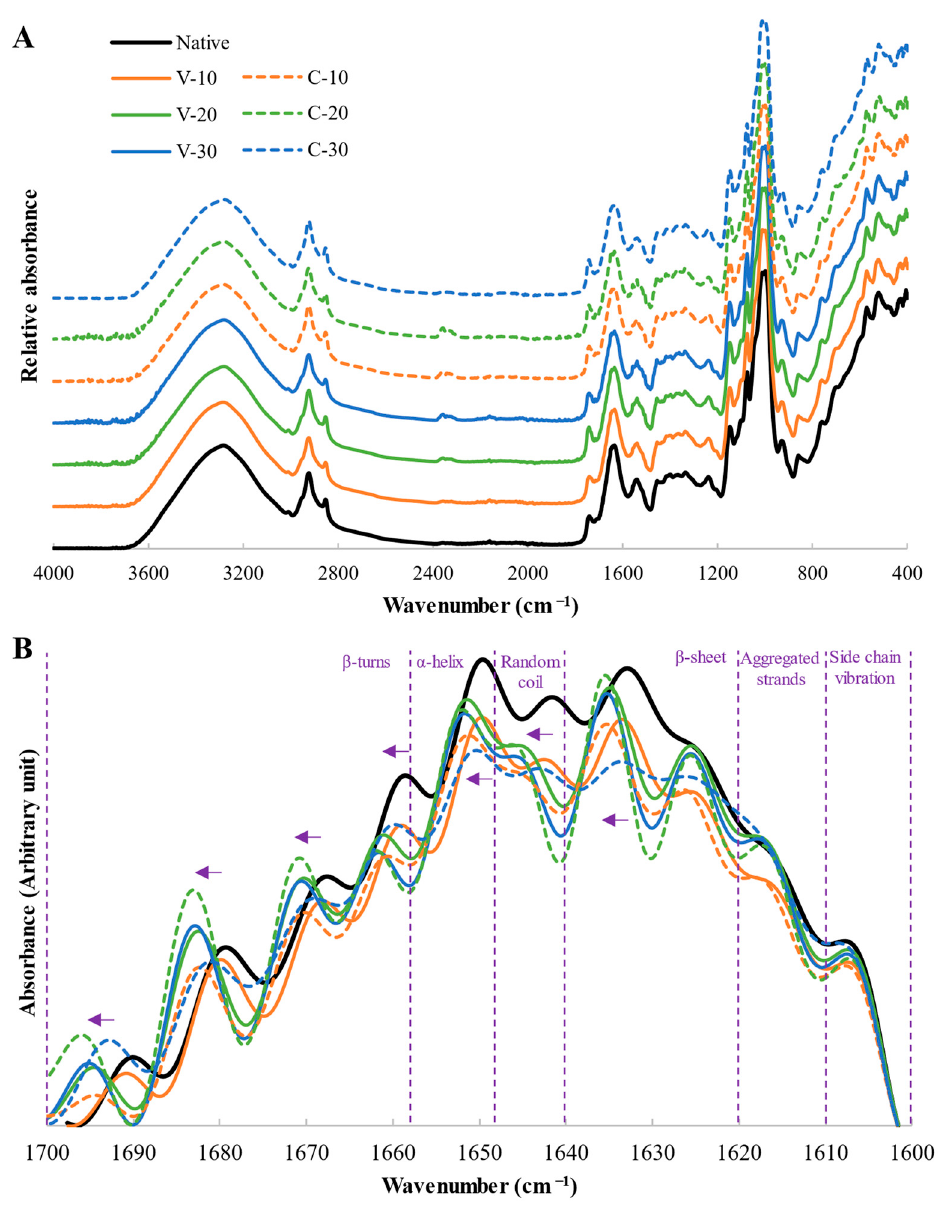
Figure 5. ( A ) FTIR spectra of the untreated flour (native) and flours obtained from microwaved grains with 10, 20, and 30% water content with treatment systems of variable (V) or constant (C) water content. ( B ) Deconvoluted FTIR spectra of the Amide I region. The different structures are represented, and the arrows indicate the wavenumber shift in the treated samples.